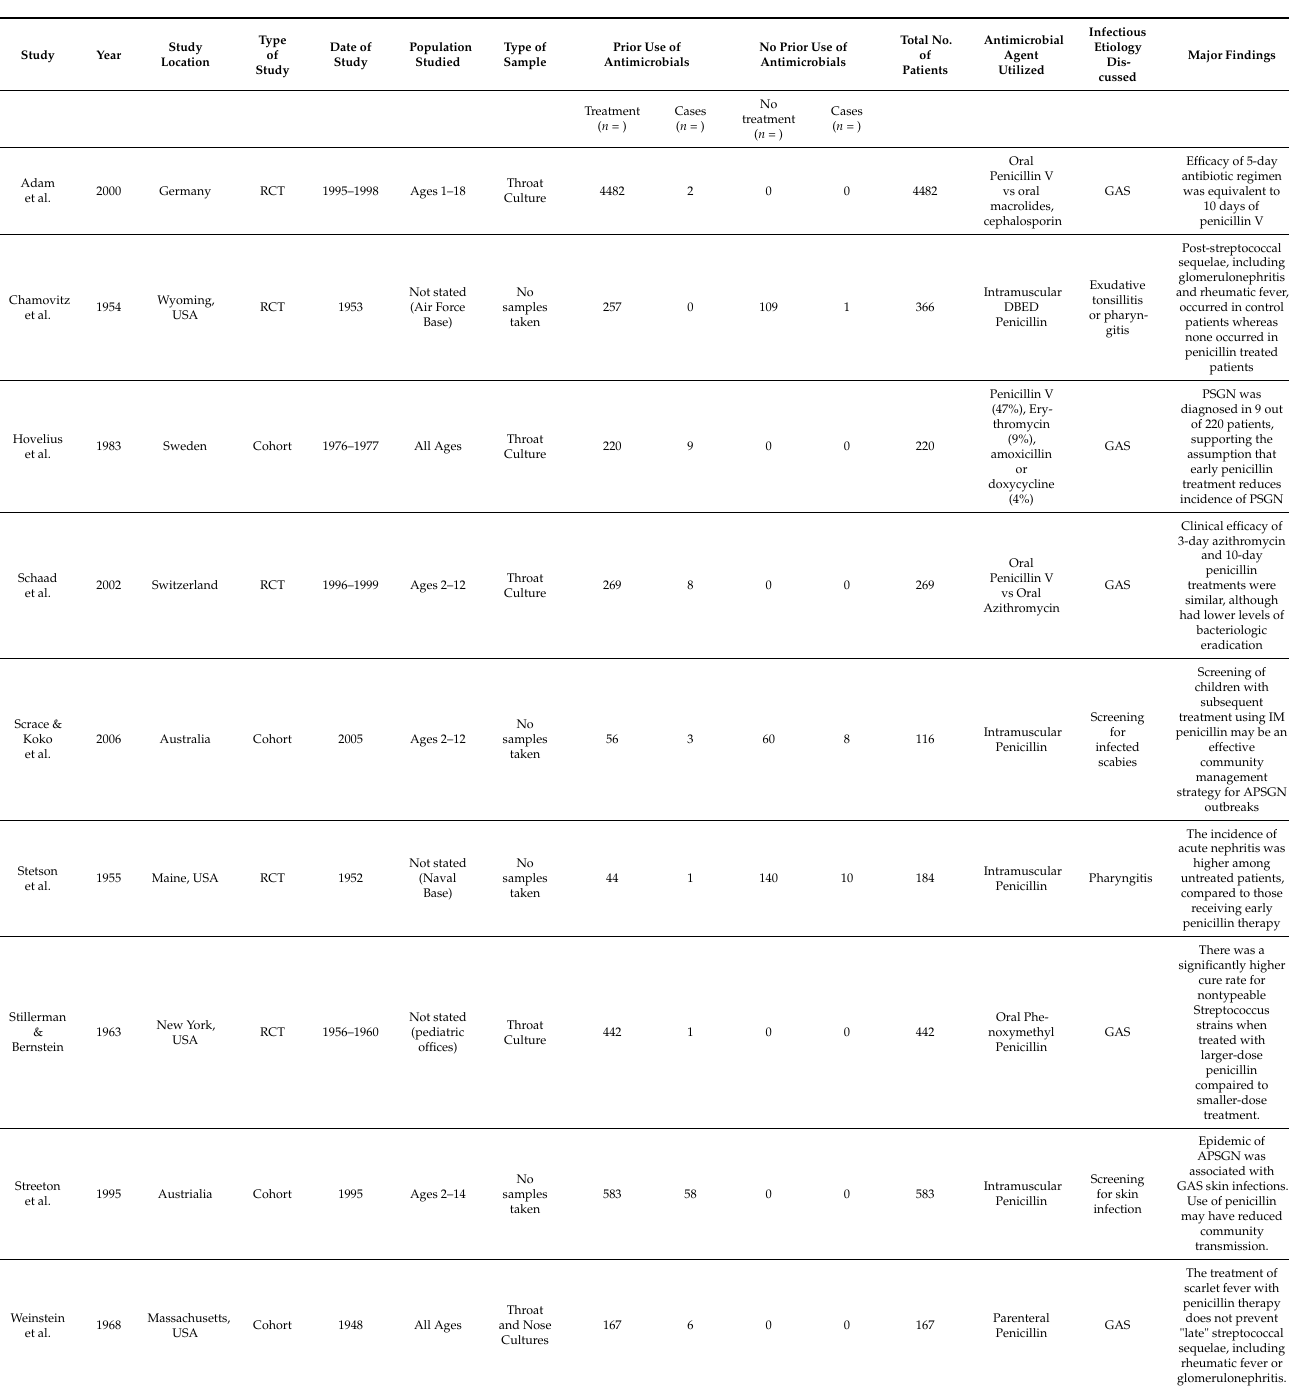
Table 1. Included studies for this meta-analysis, with information regarding study date, patient ages considered, confirmatory testing of initial infection (if any), type of study (Cohort vs. Randomized Controlled Trial), and number of patients treated or not treated with antibiotics and those that developed